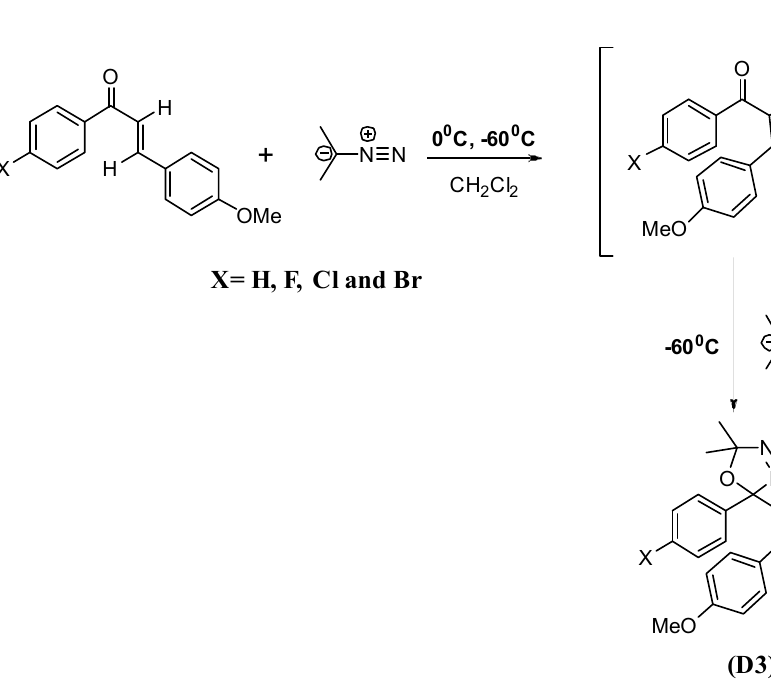
Scheme 1. Proposal mechanism of the syntheses of pyrazole derivatives